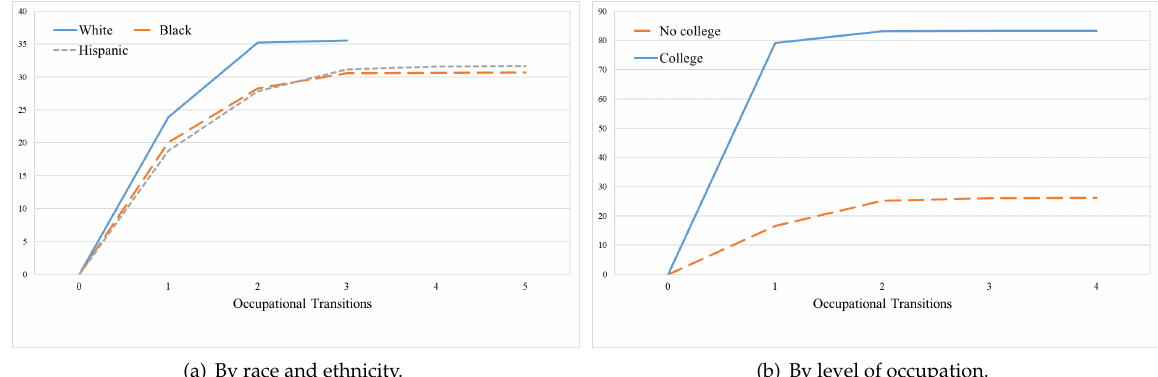
Figure 5: Percent of workers in low-status occupations achieving high-status occupations by number of transi- tions estimated using networks restricted to ties with monthly probabilities greater than 0.005 (weighted),